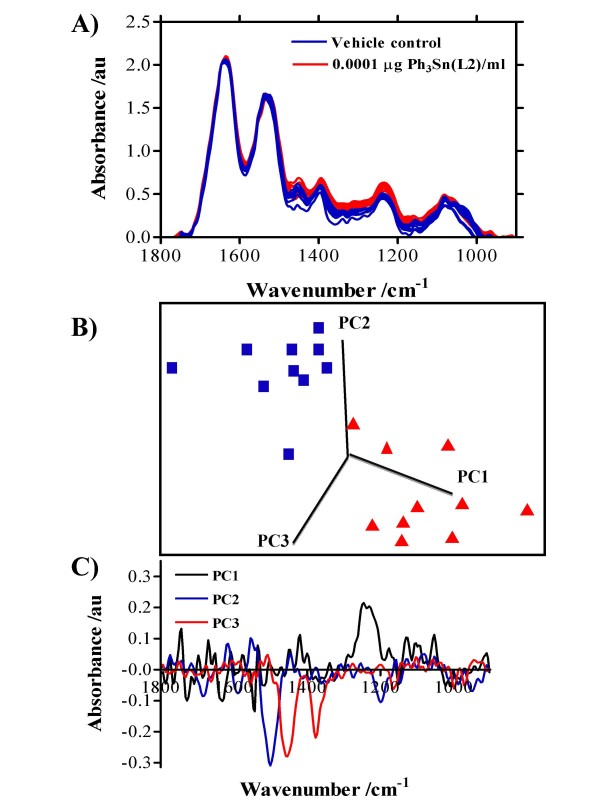
Average IR spectra of MCF-7 cells with corresponding scores plots plotted on PCs 1,2 and 3 and loadings plots following 24-h exposure to 0.0001 μg Ph3Sn(L2)/ml. Cells were seeded into 60-mm Petri dishes and allowed to attach for 24 h prior to exposure. Following exposure, cells were disaggregated with trypsin/EDTA solution, fixed in 70% EtOH, and applied to Low-E Microscope slides whereupon the suspensions were allowed to air-dry. A) 10 IR spectra were derived (vehicle control in blue, treated in red). B) From subsequent multivariate analysis, a 3-D scores plot on PCs selected to demonstrate best segregation of vehicle control (blue) vs. exposure (red) was constructed. C) Following cluster analysis, loadings plots were constructed on each relevant PC to identify the wavenumbers most responsible for segregation of clusters.